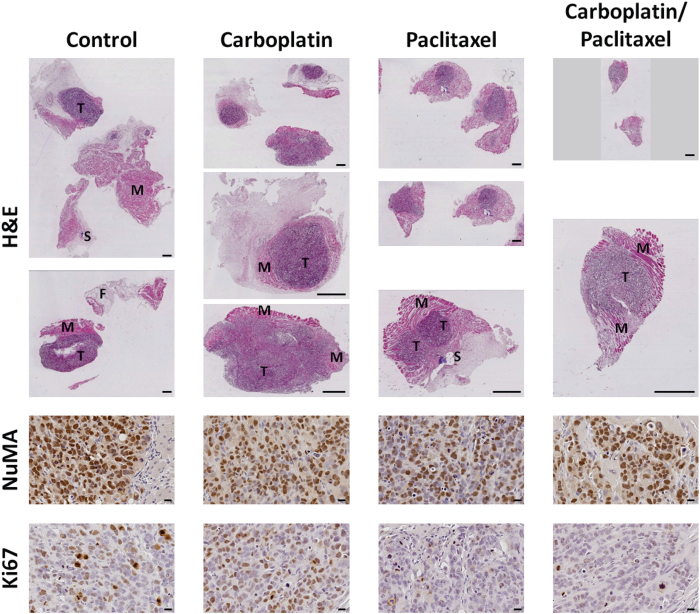
H&E staining and immunohistochemical analysis of the different treatment groups.Tissue morphology is indicated by H&E staining as an overview and close-up of the tissue samples (scale bars, 1 mm; T – tumour tissue, M – muscle tissue, F – fat tissue, S – suture). Paclitaxel-containing treatments resulted in smaller tumour regions compared to single-agent carboplatin and the control (no treatment). Representative images of nuclear NuMA and Ki67 stainings are indicated in brown for all groups, with the control and single-agent carboplatin groups showing a higher number of proliferating cells (scale bars, 20 μm).